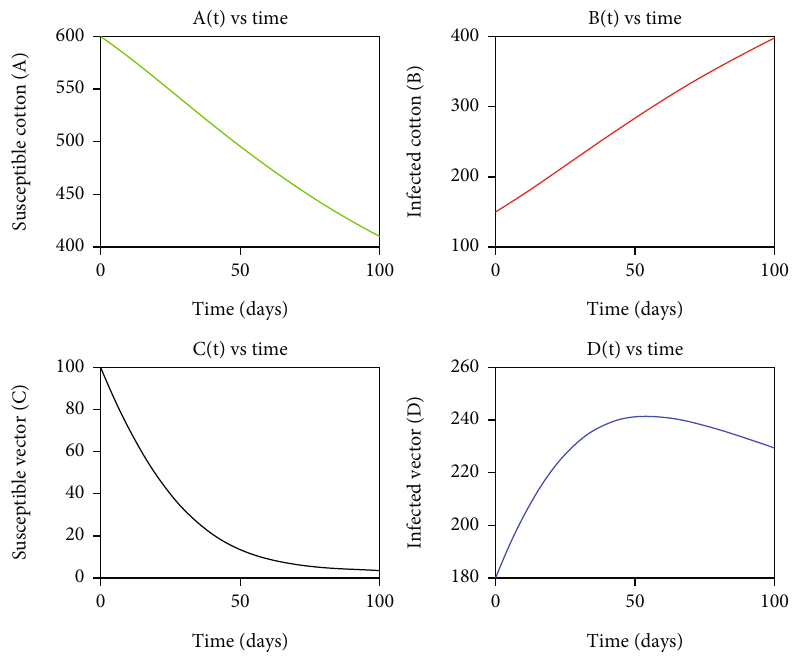
Figure 3: Time series plot of state variables for R